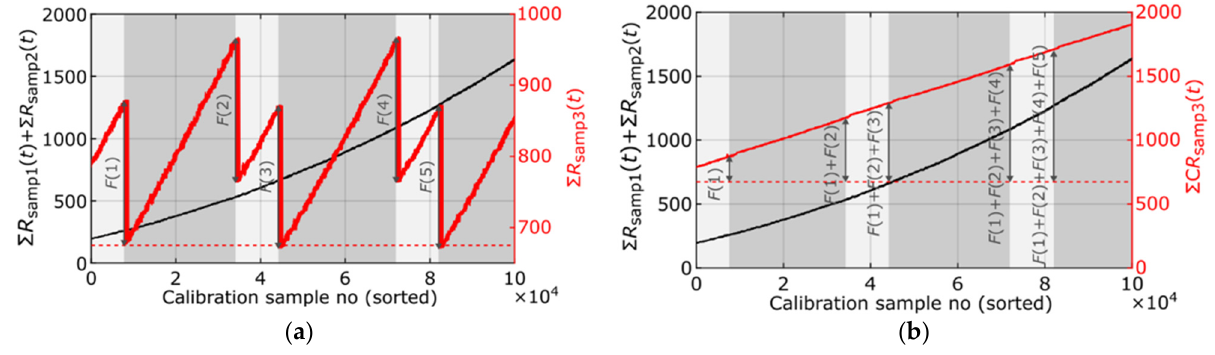
Figure 7. Post-encoder data processing: ( a ) before and ( b ) after correction. Correction factors ( F ) are added to selected Σ R samp3( t ) and Σ R samp4( t ) in order to obtain a monotonic transfer function. Values Σ R samp3 ( t ) and Σ R samp4 ( t ) change non-monotonically with respect to increasing